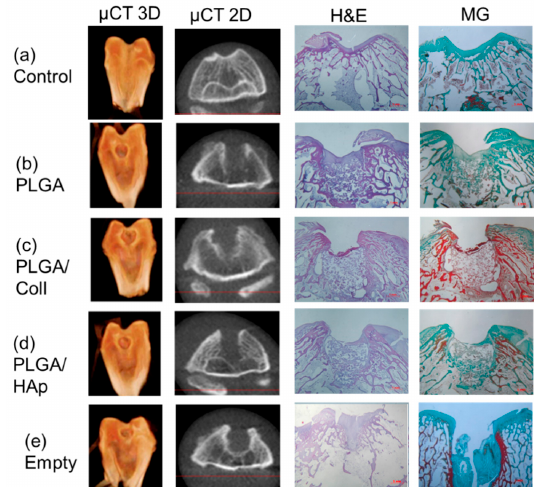
Figure 4. Computer tomography in 3D and 2D projection (first and second column) and histological evaluation after hematoxylin and eosin (third column) and Masson-Goldner staining (fourth column) 4 weeks post-implantation: ( a ) — control, ( b ) — defect filled with PLGA scaffold, ( c ) — defect filled with PLGA/coll scaffold, ( d ) — defect filled with PLGA/HAp scaffold, ( e ) — empty defect.